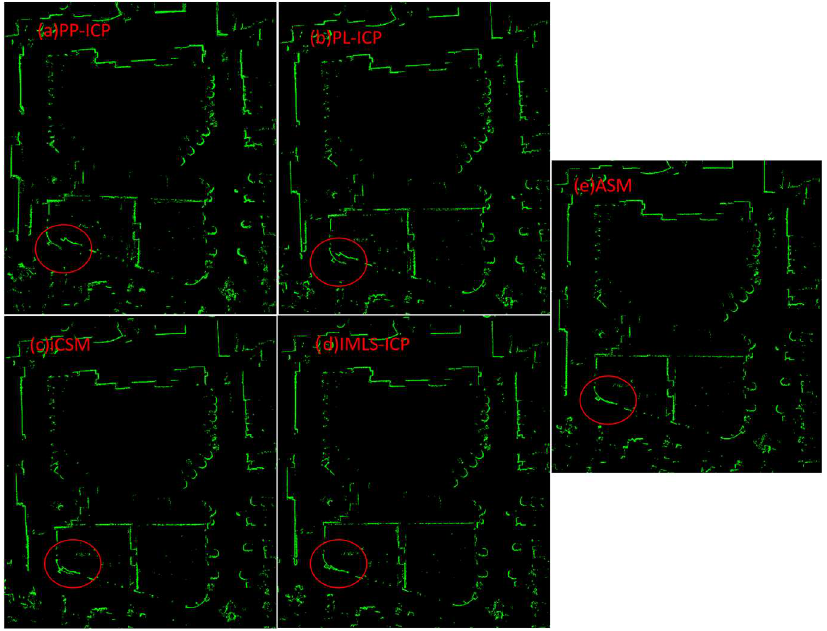
Figure 7. Office maps.